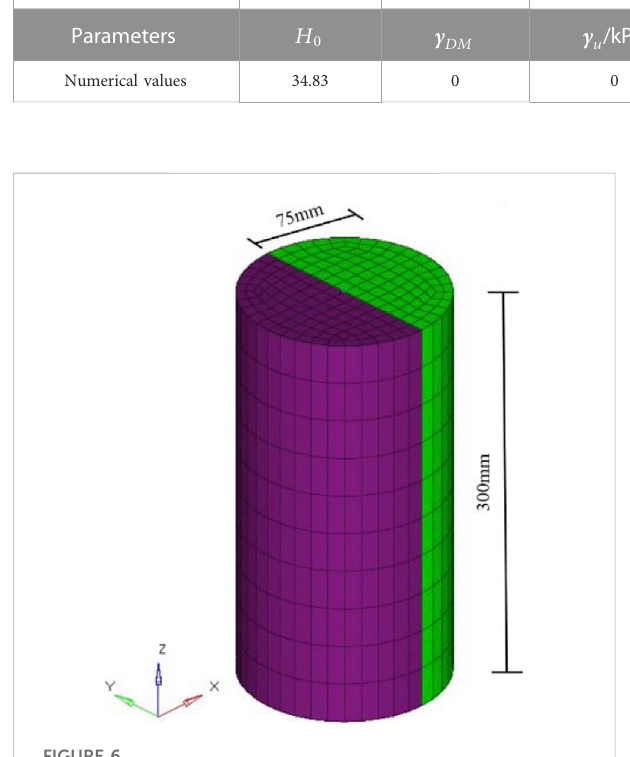
FIGURE 6 Simulation diagram of actual specimen for triaxial